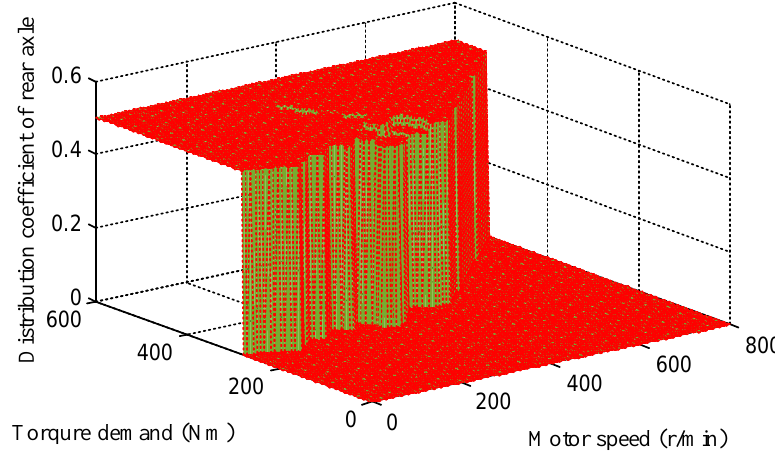
Figure 6. Optimization results of rear-axle torque distribution coefficient.